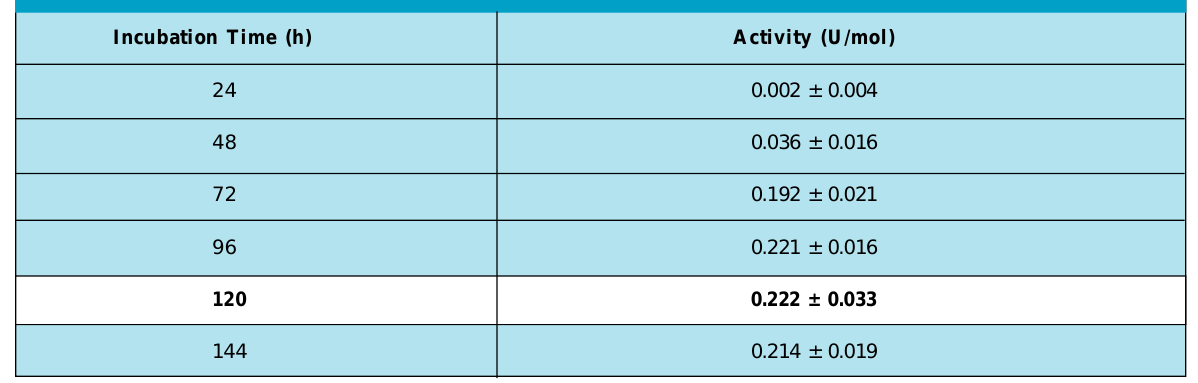
Table 1: Effect of Incubation Time on Alpha amylase